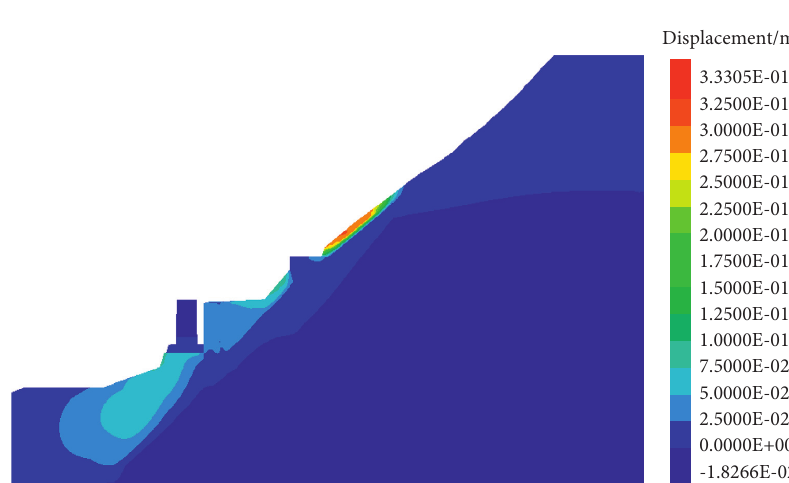
Figure 13: Cloud diagram of horizontal displacement of the slope.